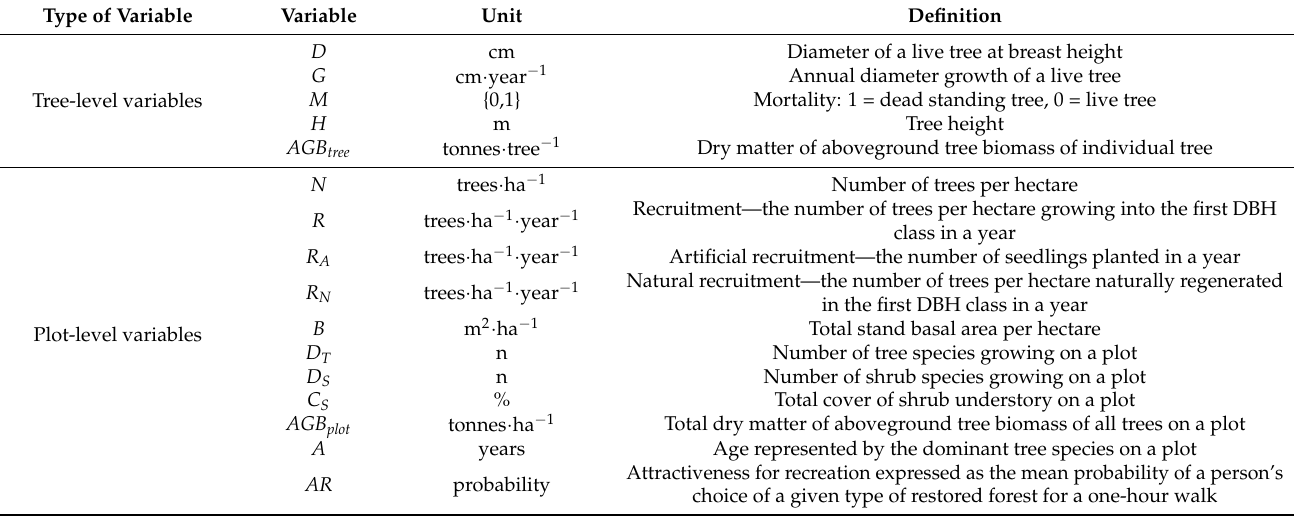
Table A3. Summary of stand variables and their